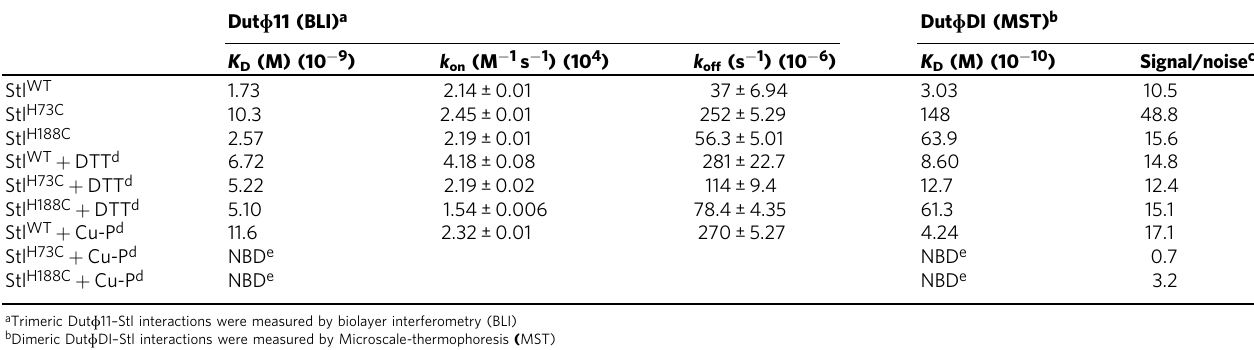
Table 2 Binding af fi nities of Stl WT and dimerization mutants for trimeric and dimeric